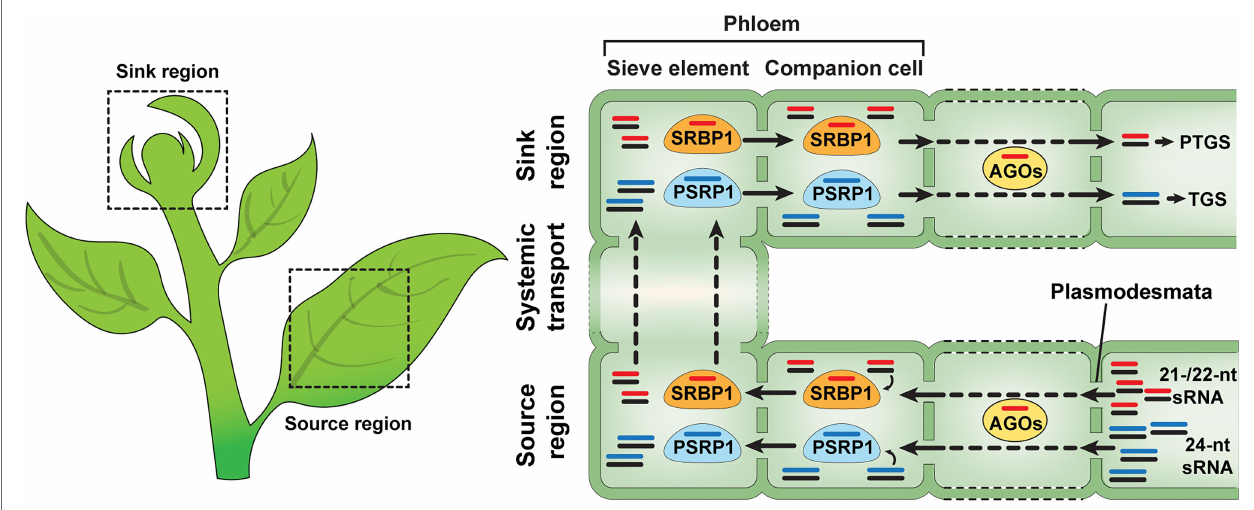
FIGURE 1 | Non-cell-autonomous sRNA trafficking in plants. sRNA duplexes are synthesized in the source regions of plants and move from cell to cell through the plasmodesmata (PD). During sRNA trafficking, mobile sRNAs are consumed by ARGONAUTEs (AGOs), one of the cell-autonomous gene silencing components. PHLEOM SMALL RNA-BINDG PROTEIN1 (PSRP1) and SMALL RNA-BINDIG PROTEIN1 (SRBP1) can mediate non-cell-autonomous transport of ss-sRNAs in plants. It is likely that SRBP1 and PSRP1 prefer to bind 21 − /22-nt and 24-nt sRNA, not sRNA duplexes, respectively. All of the 21-, 22- and 24-nt sRNAs can be delivered from source to sink regions, via the phloem, and function in transcriptional and posttranscriptional gene silencing within their destined sink tissues (Yoo et al., 2004; Ham et al., 2014; Ham and Lucas, 2017; Skopelitis et al., 2018; Brosnan et al., 2019; Yan et al., 2019; Devers et al.,